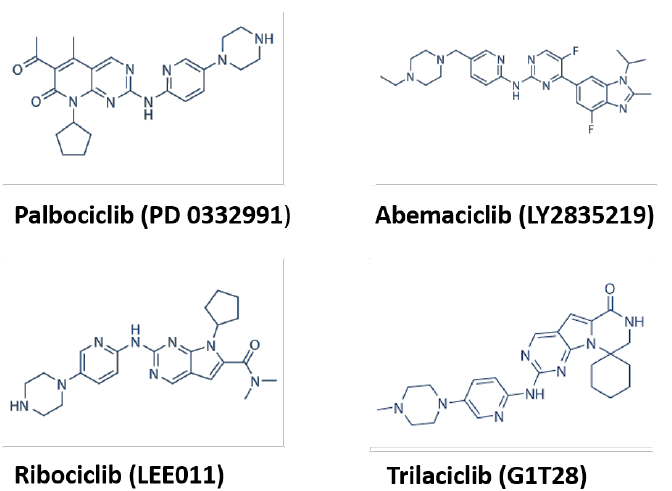
Figure 2. Chemical structures of CDK4/6 inhibitors (source: selleckchem.com (accessed on 16 January 2023)).